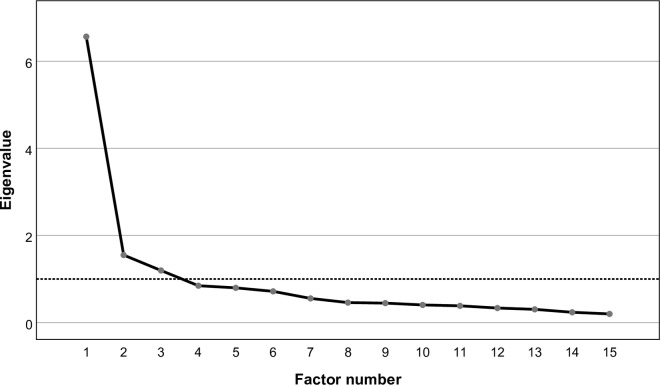
Scree plot showing the variance explained by each factors to extract.It is recommended to extract factors with a factorial load greater than 1 that are located above the "elbow" of the graph, that is, the factors above the dashed line.